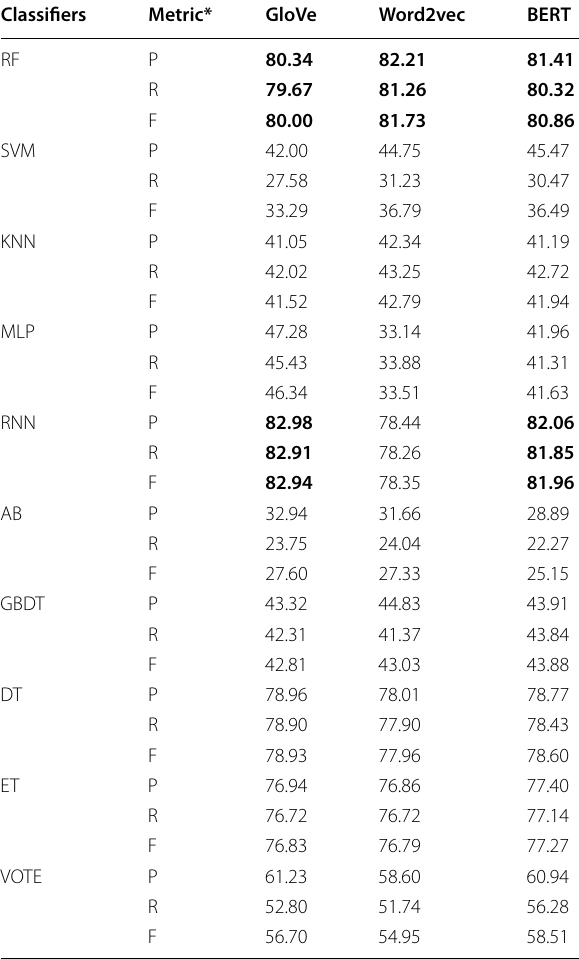
Table 15 Precision, recall, and F1-score result